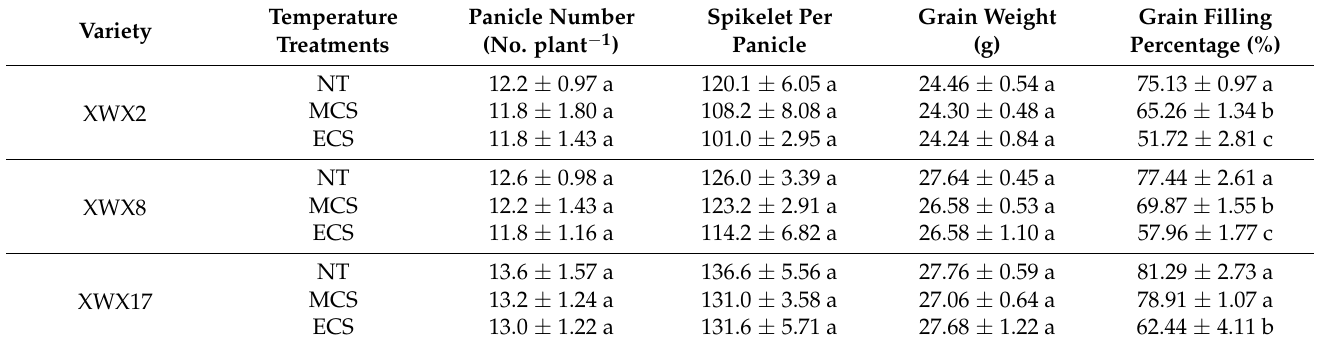
Table 2. The grain yield components of three inbred late varieties under different temperature